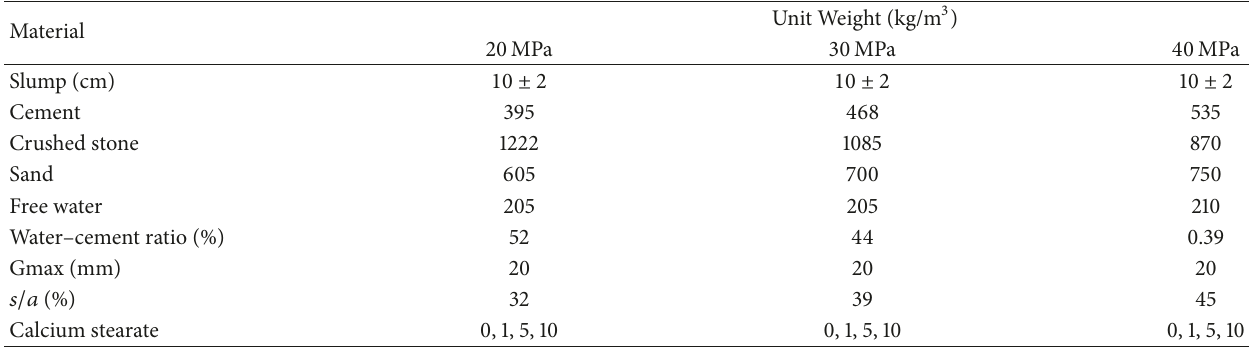
Table 1: Mix design of